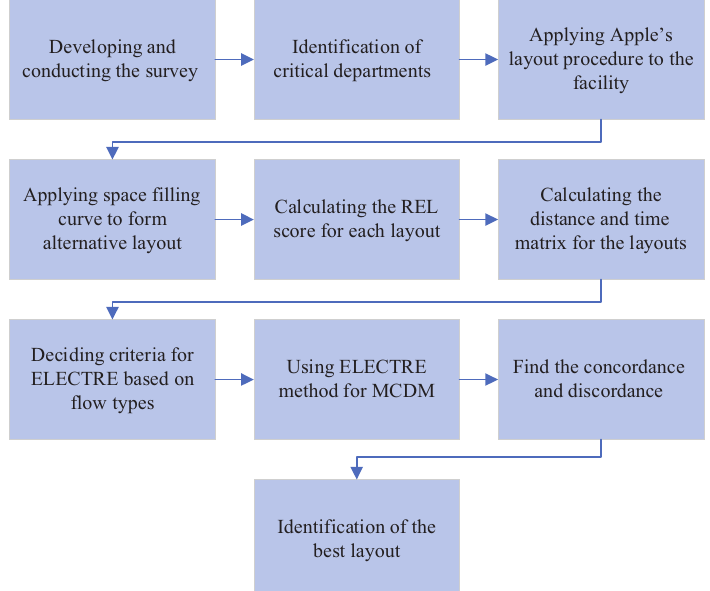
Figure 1. Flowchart for